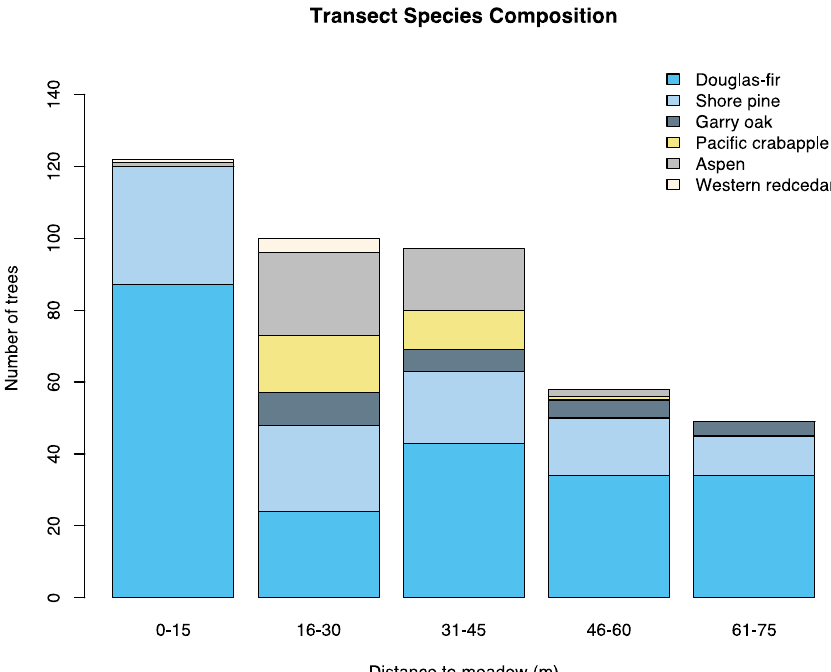
Figure 2. The composition and abundance of the six species of trees located in seven belt transects along a gradient of Garry oak maritime meadow transitioning to woodland. The greatest numbers of trees, specifically Douglas-fir trees, were located in the western Garry oak meadow at the present day forest edge.